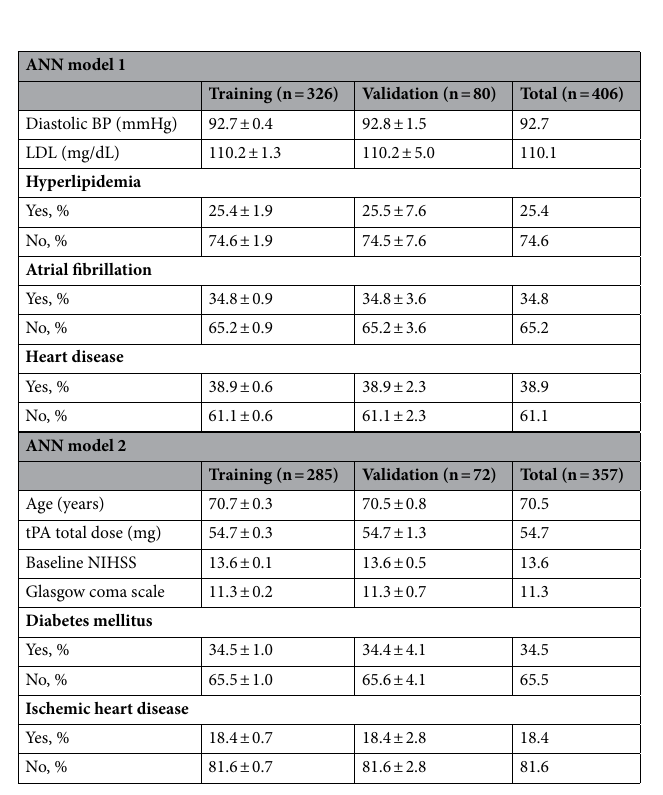
Table 3. Description of the input attributes within the training and validation datasets of the ANN models. Continuous input attributes are presented as the mean values of the attributes and the standard deviation within the five training and validation sets. Categorical input attributes are presented as the percentage of the mean case numbers and standard deviation within the five training and validation sets. ANN, artificial neural network. BP, blood pressure. LDL, low-density lipoprotein. NIHSS, National Institutes of Health Stroke Scale. tPA, tissue plasminogen